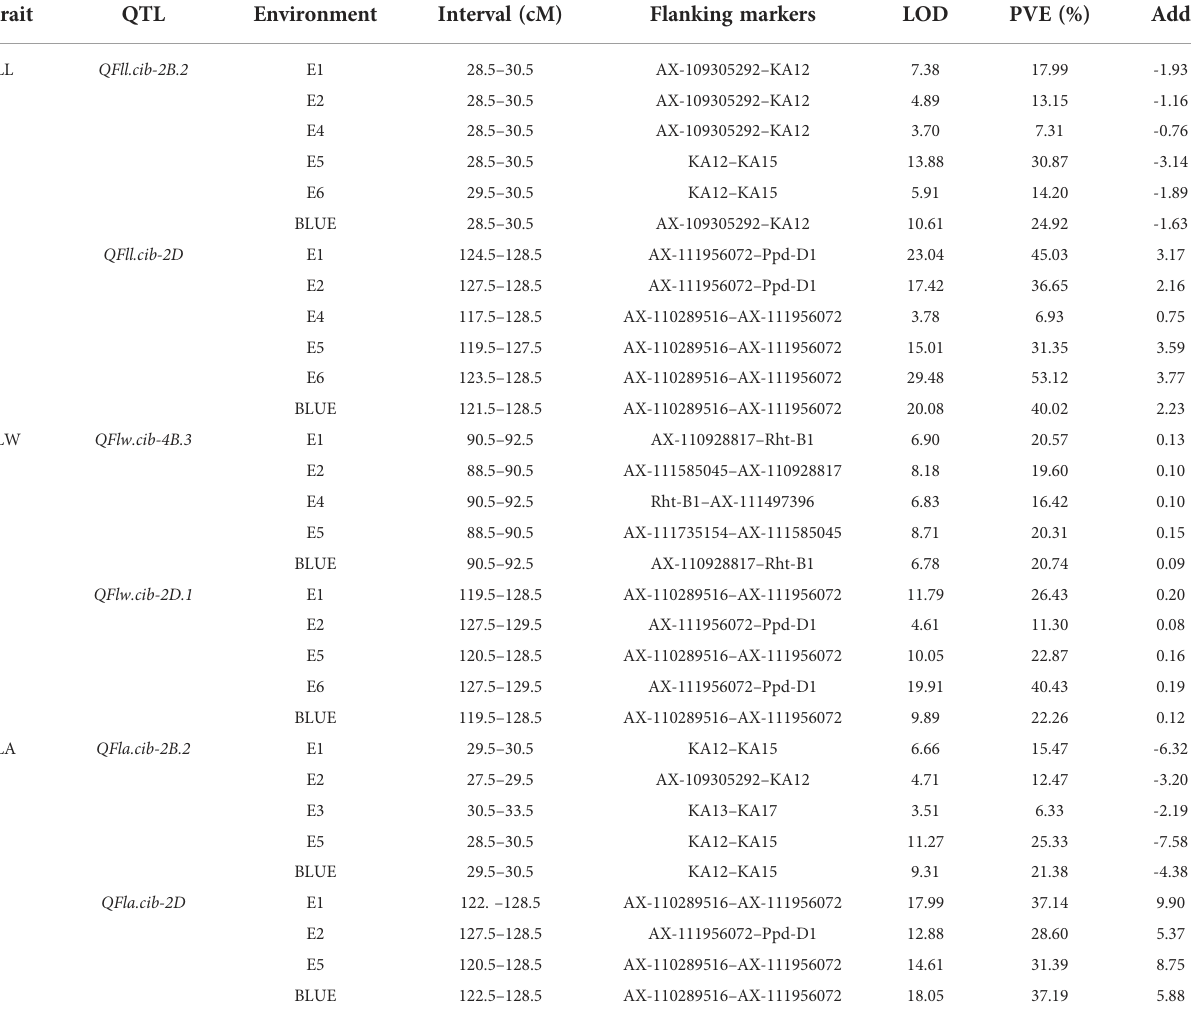
TABLE 2 Major and stable quantitative trait loci (QTL) for fl ag leaf length (FLL), fl ag leaf width (FLW), and fl ag leaf area (FLA) identi fi ed across multiple environments in the WC12 population. Trait QTL Environment Interval (cM) Flanking markers LOD PVE (%) Add FLL